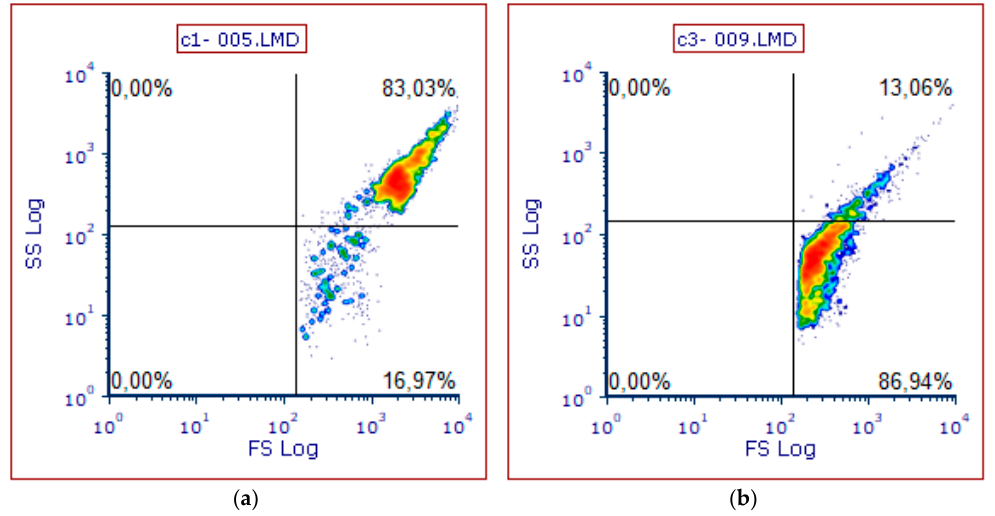
Figure 4. A representative density plot figure showing the forward (FS) and side (SS) scatter profiles of hepatocytes ( a ) and nonparenchymal cells ( b ).